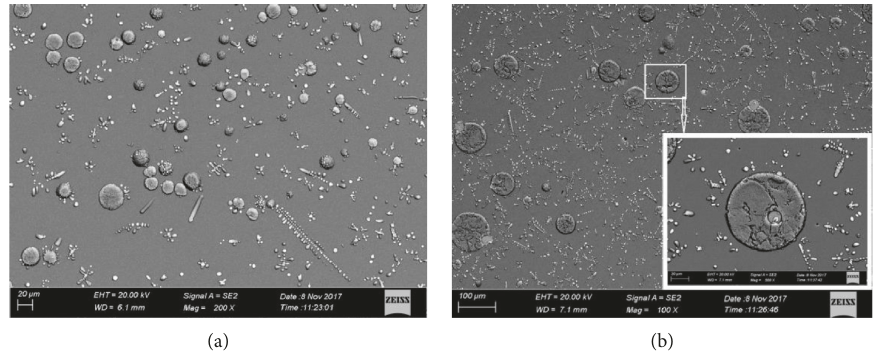
Figure 4: Microstructure of Cu-15wt.% Fe at different undercooling states: (a) ∆ T � 75K; (b) ∆ T �